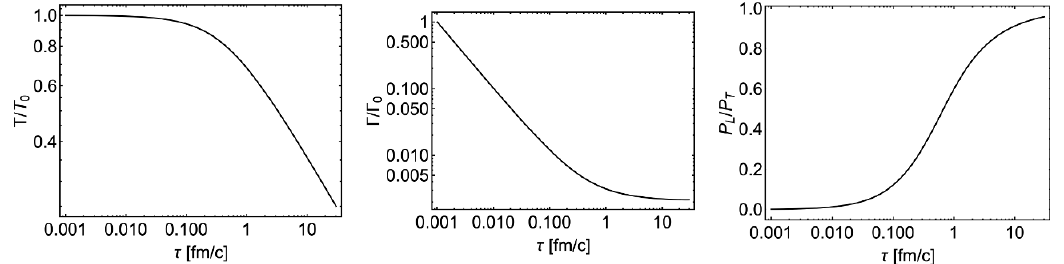
Figure 2 . Three panels showing (left) the scaled e(cid:11)ective temperature, (middle) the scaled fu- gacity, and (right) the pressure anisotropy as a function of time for \attractor" initial conditions (cid:28) 0 = 10 (cid:0) 3 fm/c, T 0 = 1 GeV, (cid:11) 0 = 2 : 5 (cid:2) 10 (cid:0) 2 , and (cid:0) 0 =